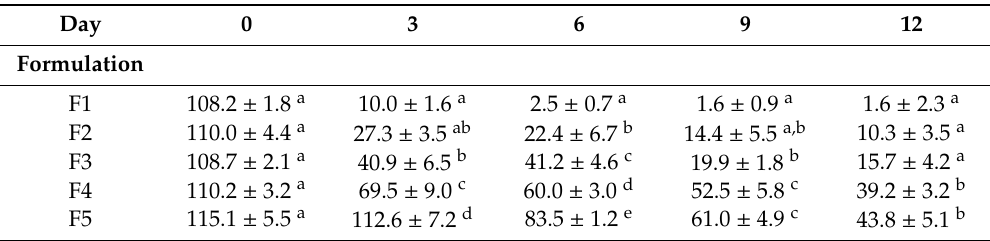
Table 5. Evolution of the Firmness (N) in tomatoes with CS + RGEO treatments: F1 = control, F2 = CS, F3 = CS + RGEO 0.5%, F4 = CS + RGEO 1.0%, and F5 = CS + RGEO 1.5%. Mean values and intervals of